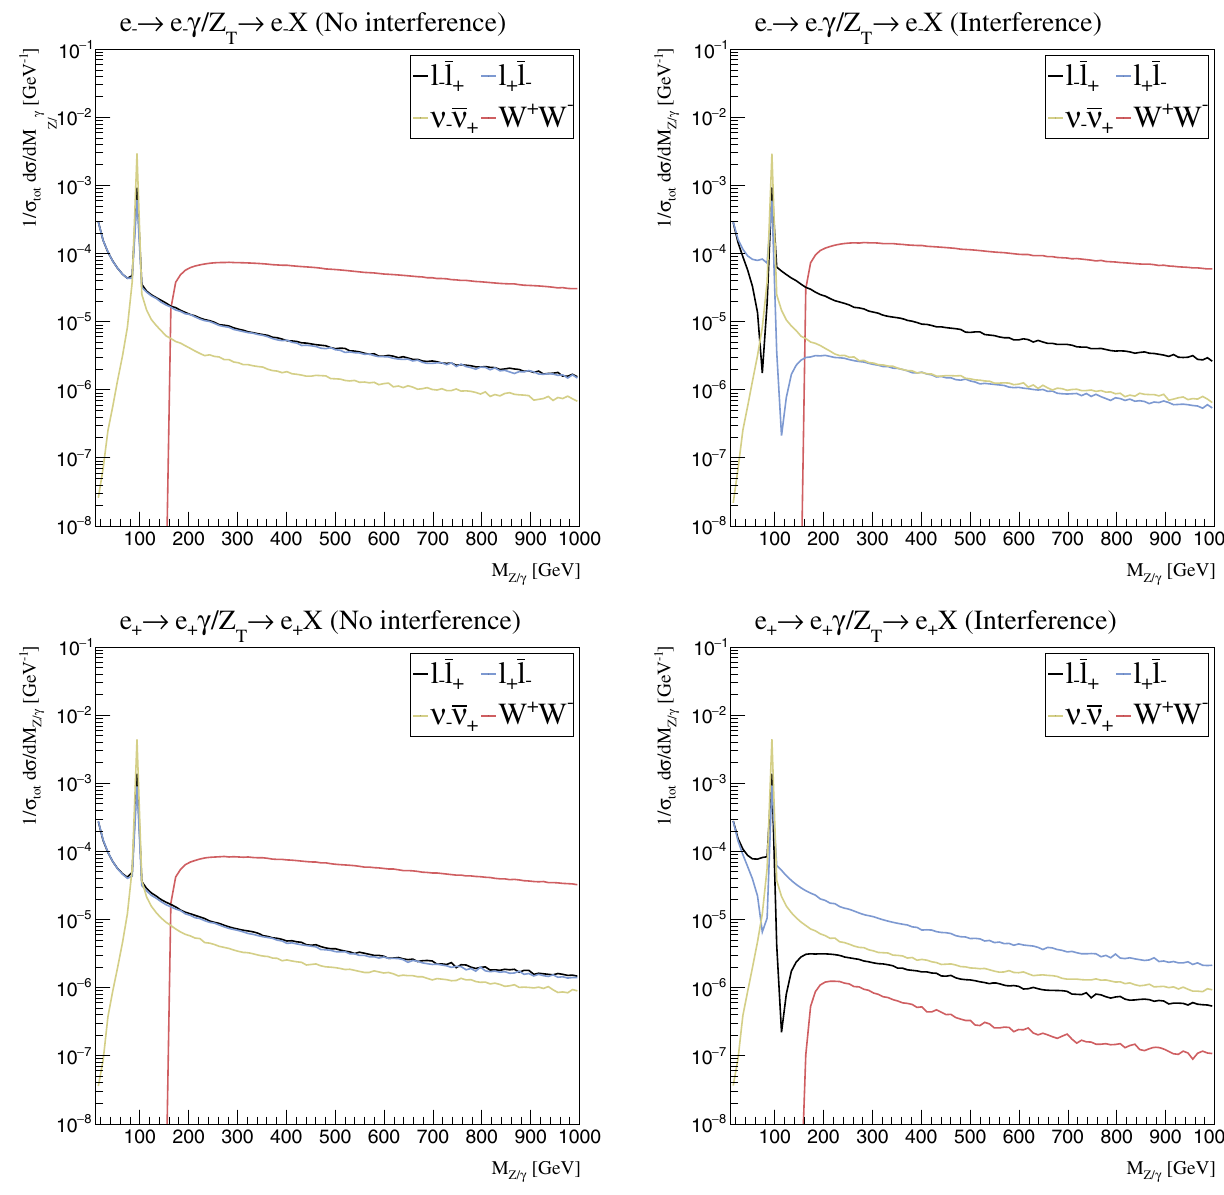
Fig. 5 Differential rates of the shower histories e − → e − γ/ Z T → e − X (top) and e + → e + γ/ Z T → e + X (bottom) without (left) and with (right) the bosonic interference correction. The showers are initiated from a 10 TeV electron with a neutral recoiler